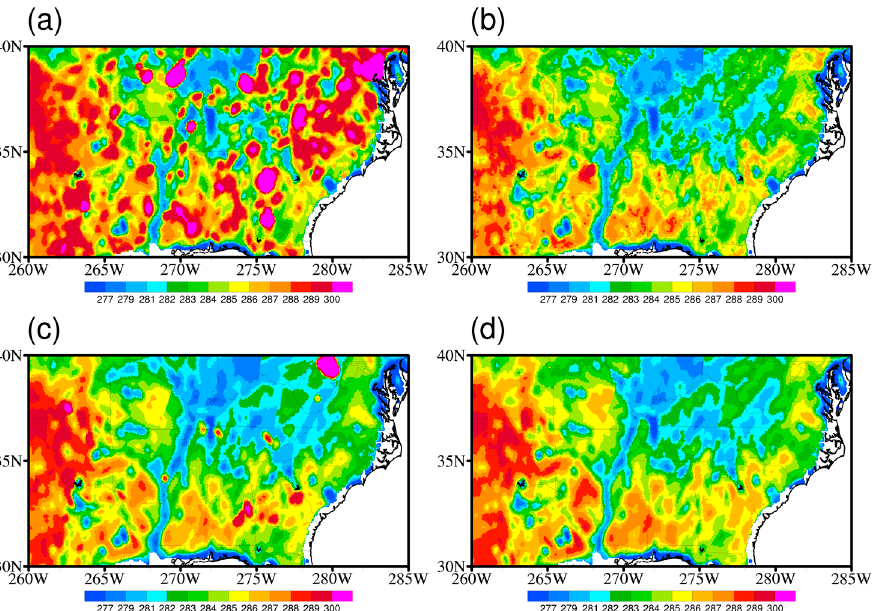
Figure 4. Spatial distributions of mean observed ( a ) and restored ( b ) brightness temperatures of the 6.9-GHz-V channel and the observed 7.3-GHz-V ( c ) and 10.7-GHz-V ( d ) channels in autumn 2016.